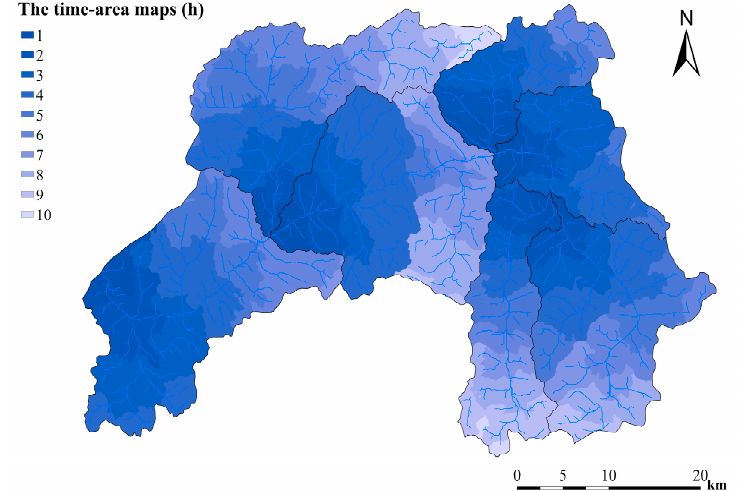
Figure 3. Isochrones of Pianguanhe’s sub-catchments.